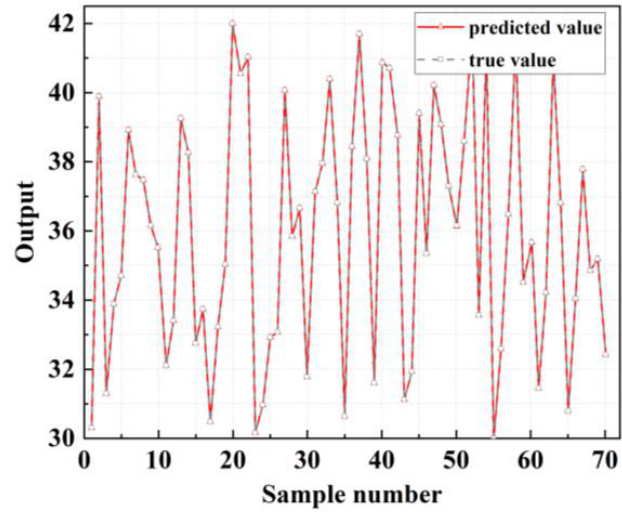
Figure 9. Ensemble of surrogates model test set test error.